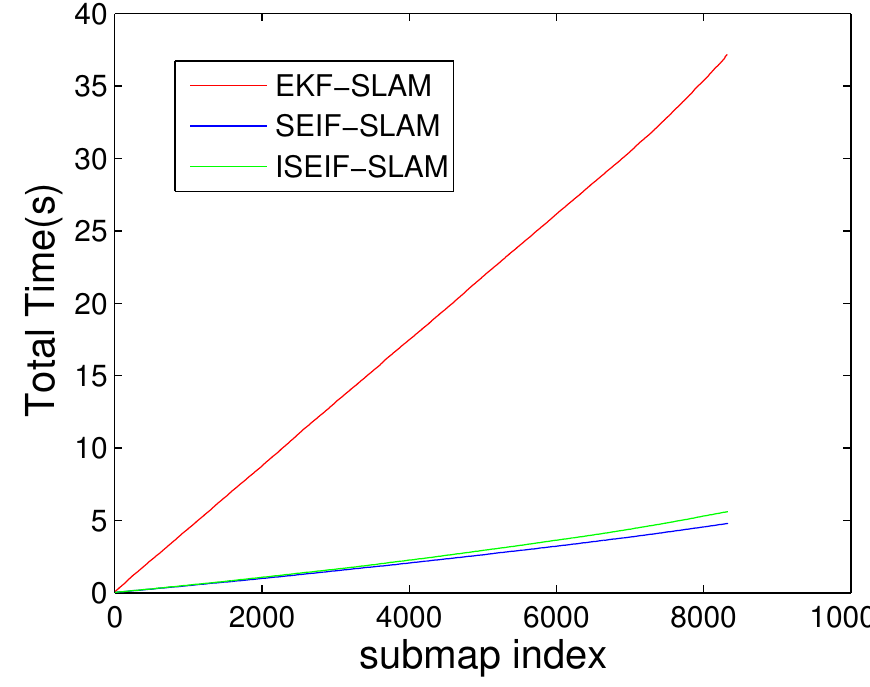
Figure 5. The comparison of average CPU time for EKF, SEIF and